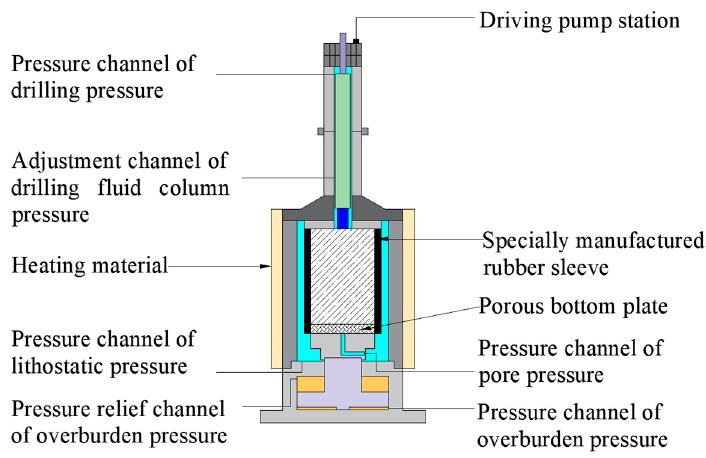
Figure 3. Schematic diagram of temperature ‒ pressure application.